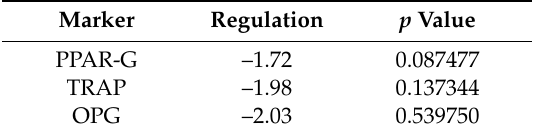
Table 3. Gene expression analysis of Cu compared to Ti (10